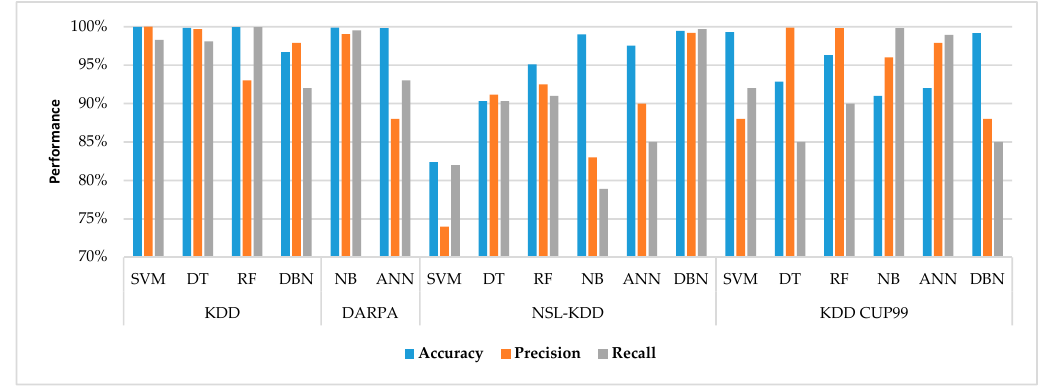
Figure 2. A comparative Analysis of Intrusion Detection using Machine Learning Techniques.